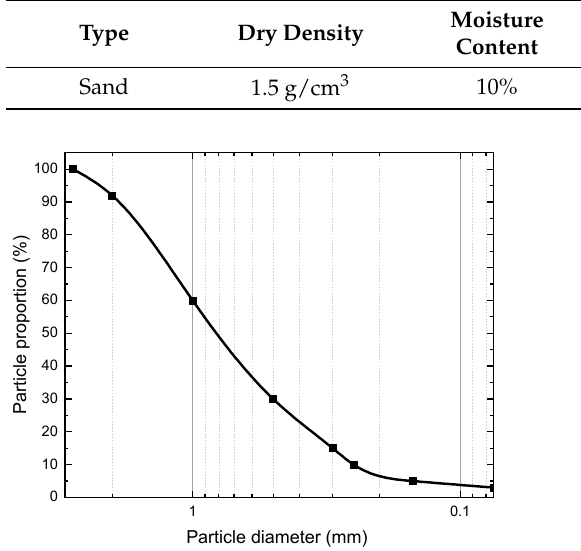
Figure 1. Gradation curves of the tested sand.